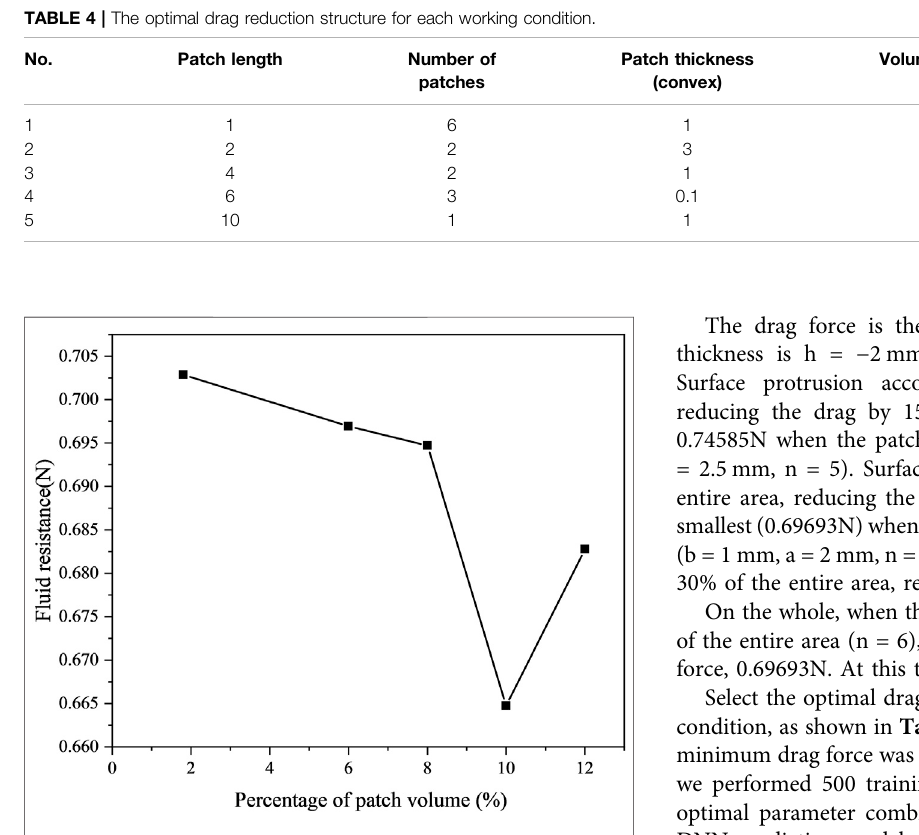
FIGURE 12 | Relationship between volume percentage and minimum drag